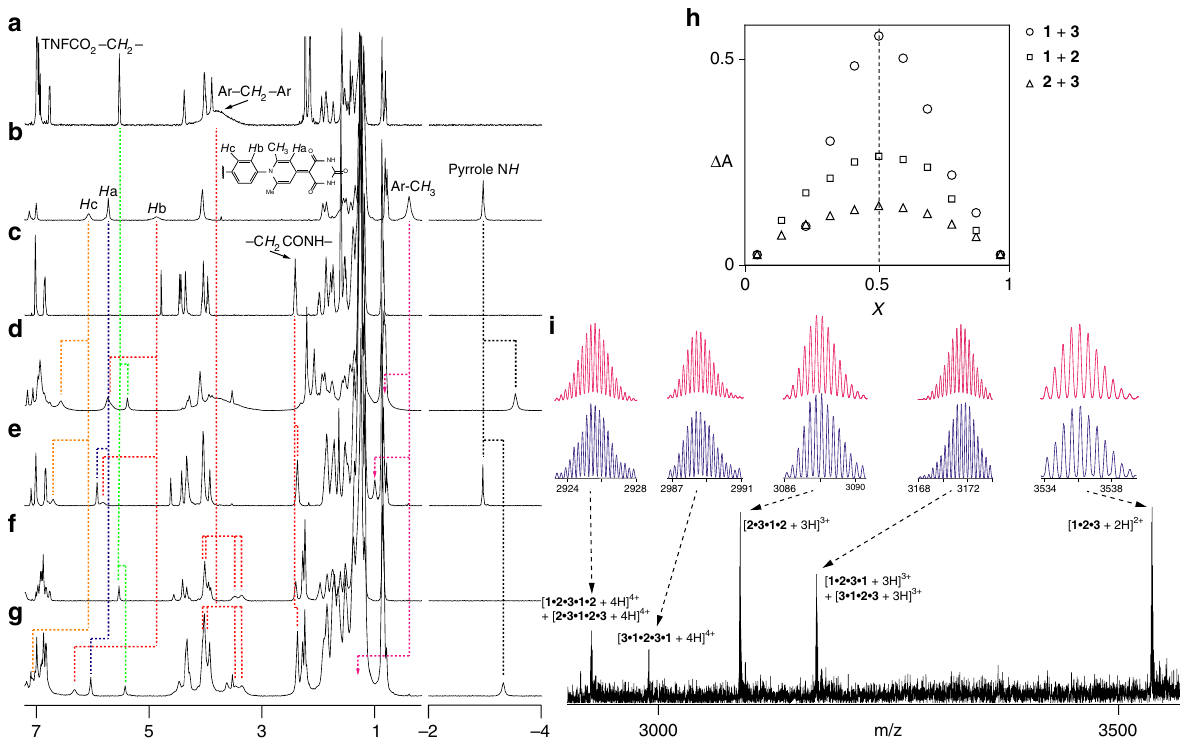
Fig. 2 Self-sorting behaviors in supramolecular terpolymerization. The 1 H NMR spectra of a 1 , b 2 , c 3 , d a mixture of 1 and 2 , e a mixture of 2 and 3 , f a mixture of 1 and 3 , and g a mixture of 1 , 2 , and 3 in chloroform- d 1 . h Job plots for the 1 (cid:129) 2 , 2 (cid:129) 3 , and 1 (cid:129) 3 heterodimeric complexes. i ESI-MS spectrum of a mixture of 1 , 2 , and 3 . Observed isotope distributions are highlighted in blue , and the calculated distributions are highlighted in